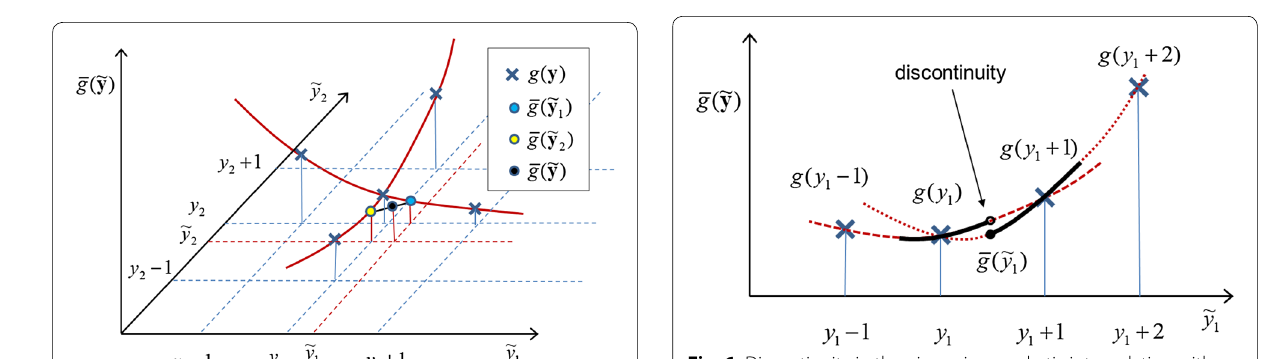
Fig. 6 Discontinuity in the piecewise quadratic interpolation with one